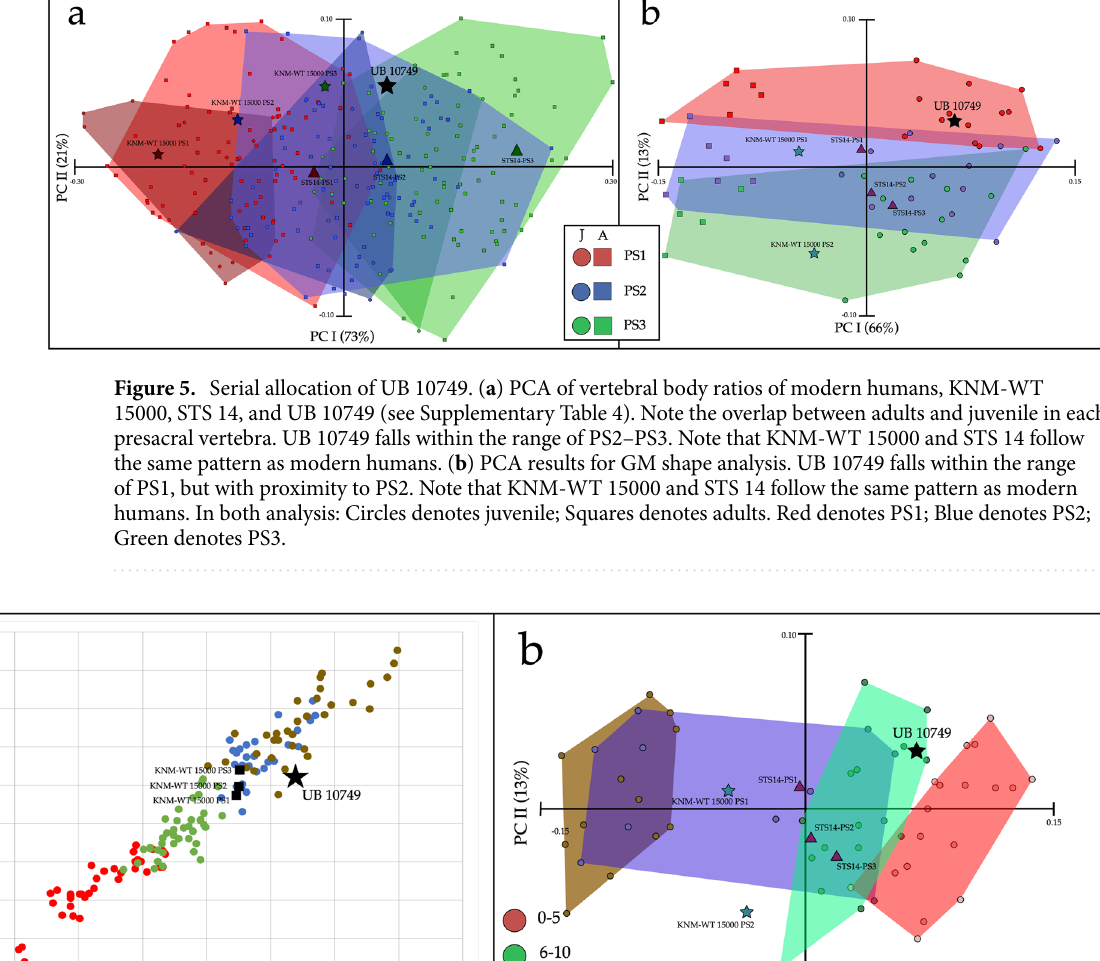
(Supplementary 2: Fig. 4). Considering all the above information, we estimate that the age at death for UB 10749 is between 6 and 12-years-old. Height and weight estimation. Height (stature) and weight at death is estimated based on a range of equations and growth charts for modern humans (Supplementary 2: Tables 6–8). The estimated average height at death of UB 10749, points to a height of 155 cm. This height is comparable to a 13 years-old boy or a 12.5 years- old girl, based on CDC growth charts. A height of 155 cm is above the 95 percentile of 10 years old and above the 75 percentile for 12 years old modern humans 29 . As the age estimation for UB 10749 is 6–12 years, it seems that this individual was tall for its age. Weight is estimated based on height or based on chronological age. Based on height, UB 10749 was 45–55 kg, while based on age, the weight of UB 10749 was 20–43 kg (Supplementary 2: Table 7). Since height is a stronger predictor for weight than age 30 , we estimate the weight at death at about 45–50 kg. A single juvenile vertebral body is not a definitive predictor for adult height and weight. Even more so, the growth pattern of early Pleistocene hominins is unknown. Thus, to cautiously estimate the adult height and weight of UB 10749, calculations were based on several methods: modern American (CDC growth charts), modern Sudanese population 31 , and chimpanzees 32 .